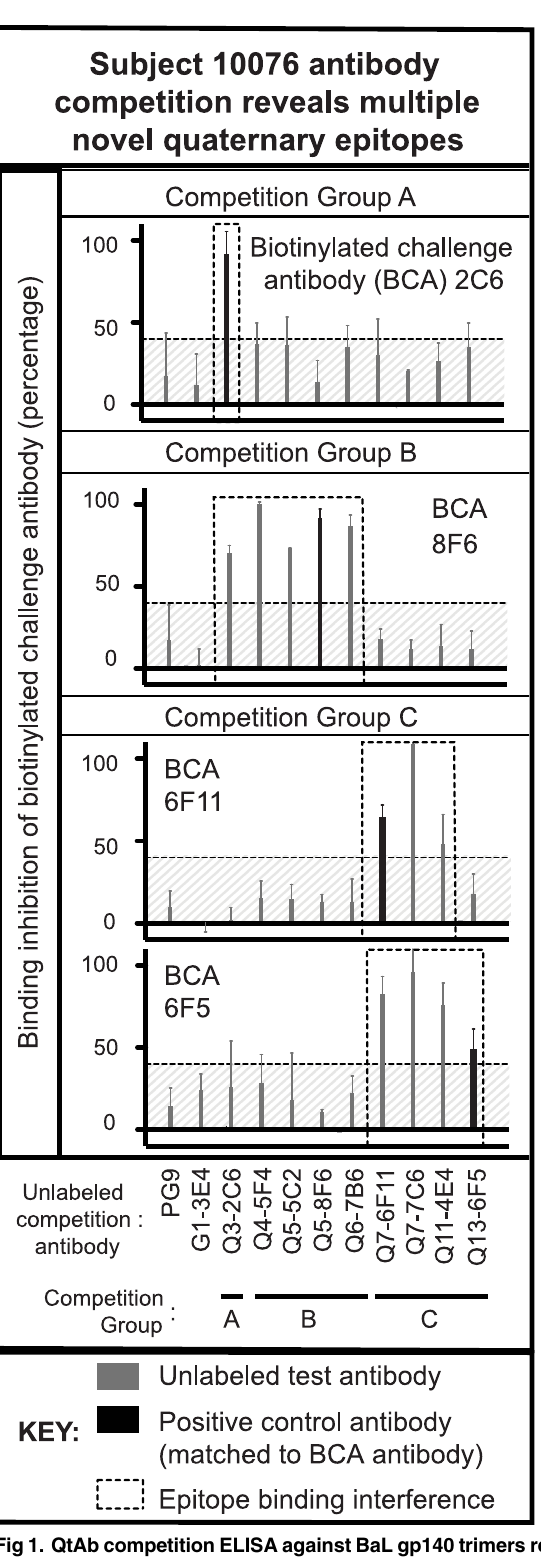
Fig 1. QtAb competition ELISA against BaL gp140 trimers revealed multiple novel quaternary epitopes. Each frame represents competitive binding against a different biotinylated competitor Ab (BCA) (using QtAbs 2C6, 8F6, 6F11, or 6F5). Unlabeled Ab to BCA ratios of 2:1 (based on EC 50 values) are